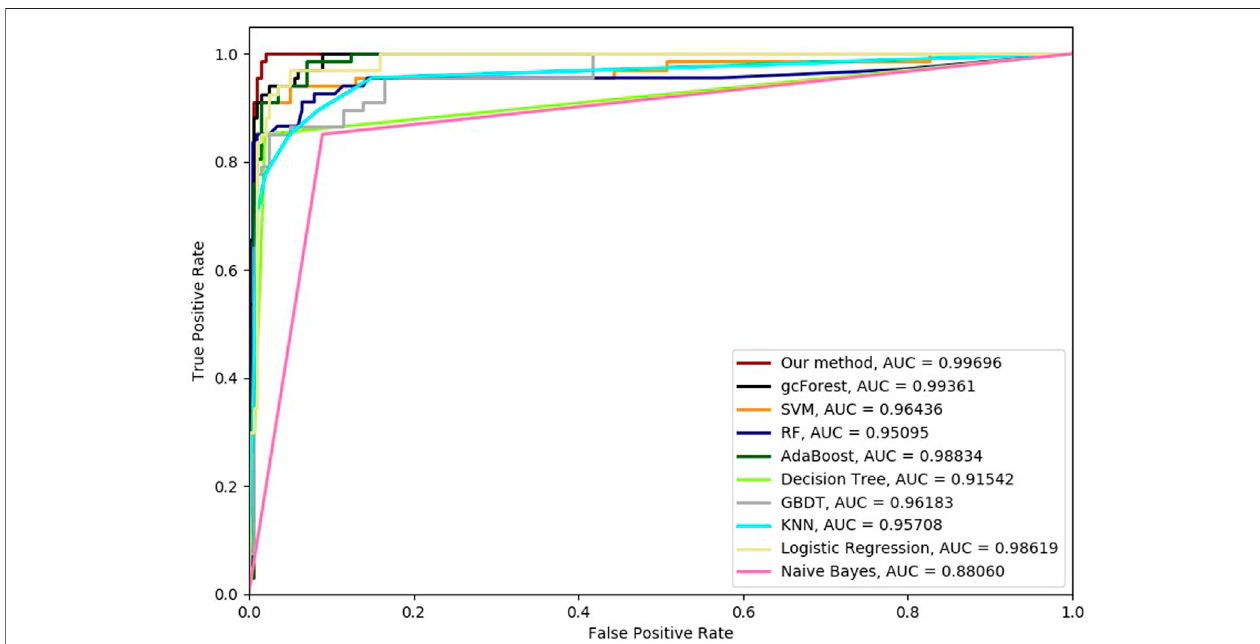
FIGURE 8 | Hypertension-related compound identi fi cation performances of ten methods with 10-cross validation methods.